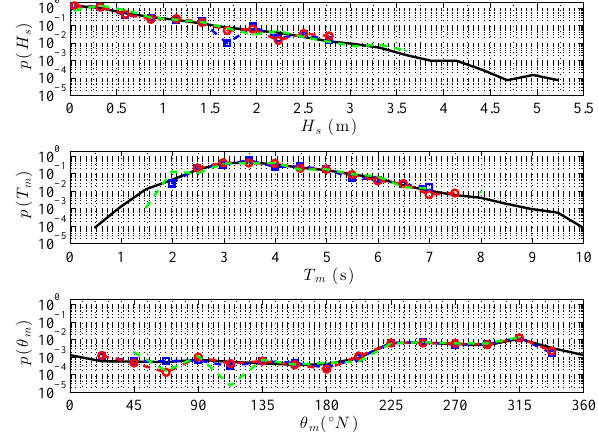
Figure 9. MDA-SOM: comparison between original (black solid lines) and resulting histograms representing the PDFs of H s (top panel), T m (central panel) and θ m (bottom panel), for the whole pe- riod of observations. Data set reduction: 80% (blue dashed-squares line), 60% (red dashed-circles line) and 10% (green dashed line).